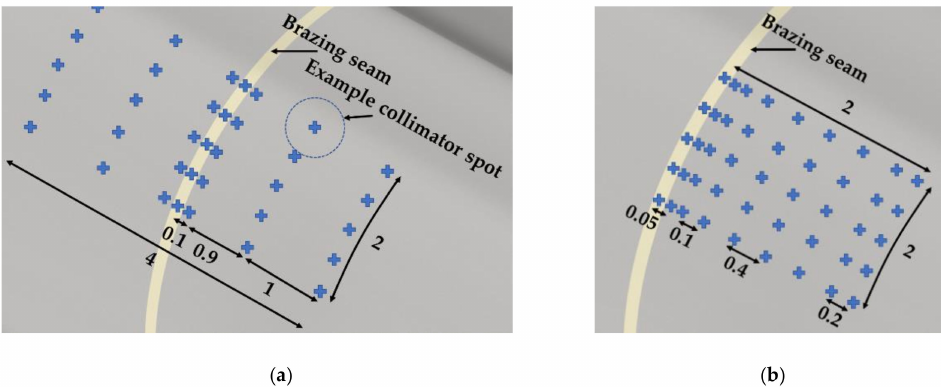
Figure 4. Measuring points on the specimen surface for ( a ) all brazed joints and ( b ) only ST20 40min for detailed analysis (all dimensions in